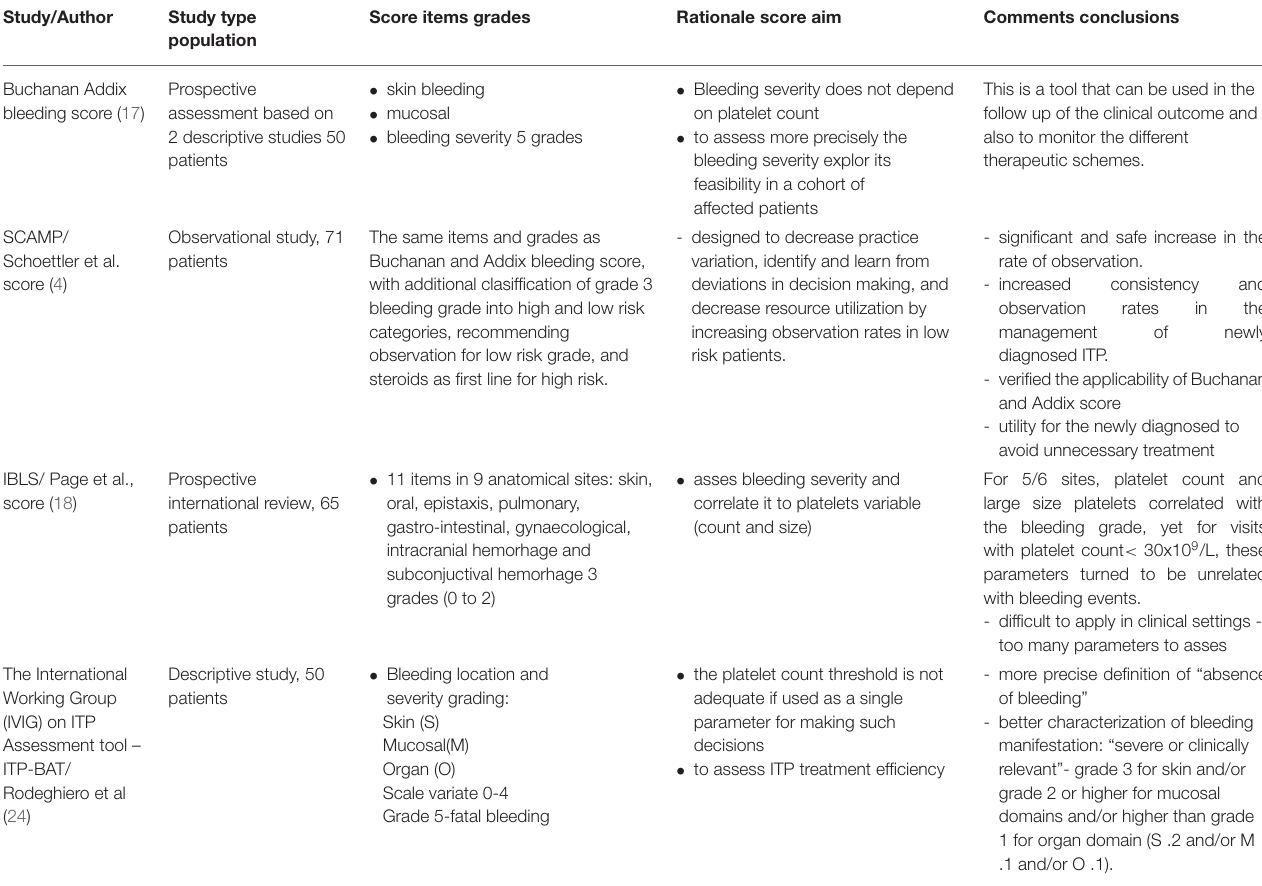
TABLE 1 | Summary of the main bleeding severity assessment